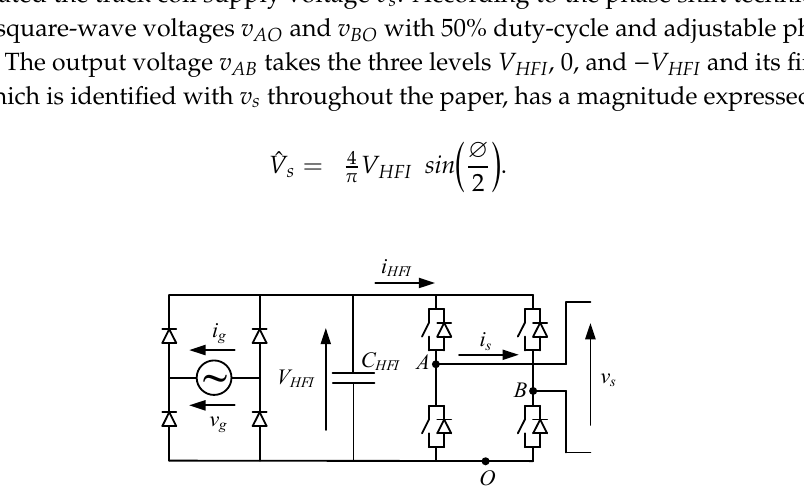
Figure 4. Mutual inductance profiles.